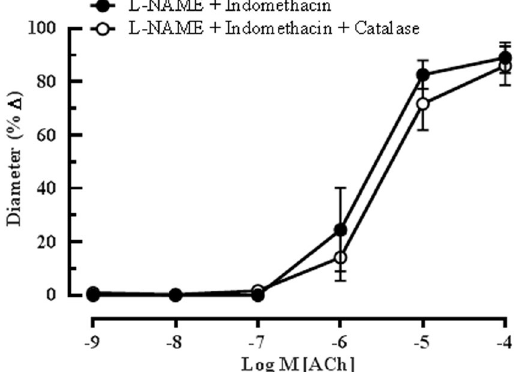
Figure 3. Catalase elicited negligible inhibitory effect on ACh-induced vasodilation. Blocking of H 2 O 2 , a putative EDHF, with catalase (1000 units/ml) in combination with L-NAME and indomethacin in the eNOS − / − mouse ophthalmic artery did not produce significant attenuation of vasodilation. Values are expressed as mean ± s.e.m (n = 6 per group).